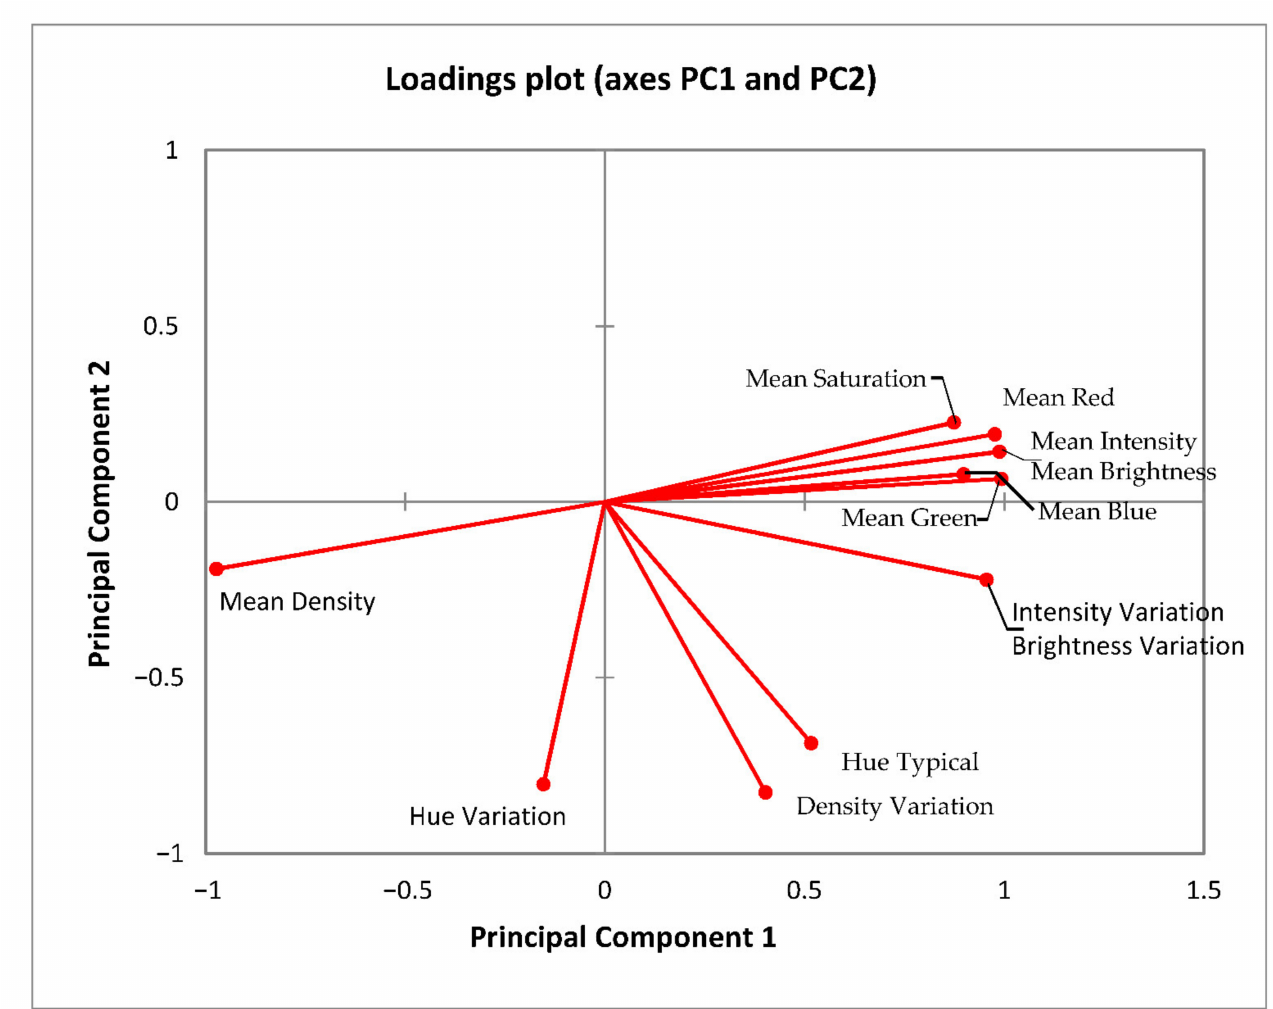
Figure 3. Similarities and dissimilarities of colour features for biscuits classification. The two-dimensional loadings plot of Principal Component 1 and Principal Component